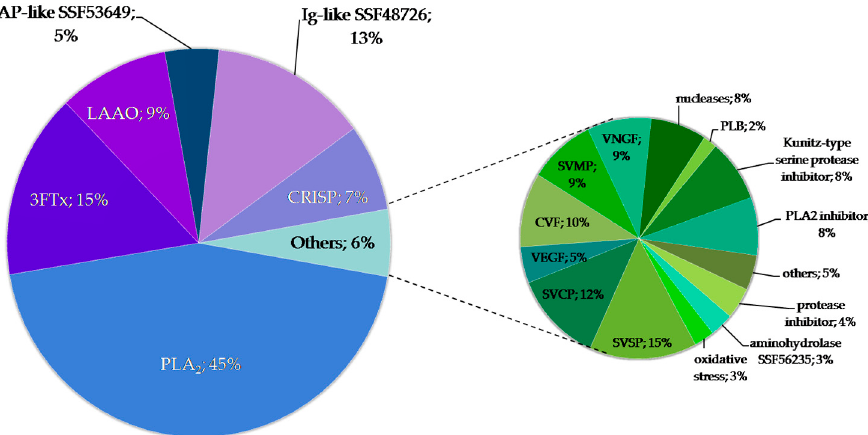
Figure 5. Detailed percentage distribution of identified proteins in fraction F2. LAAO—L-amino